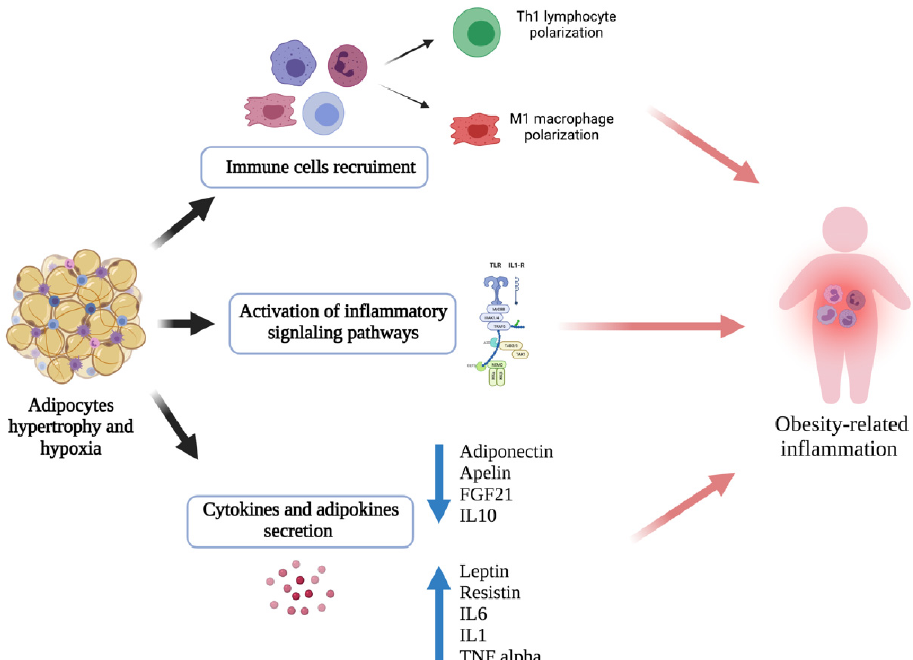
Figure 1. Adipose tissue and obesity ‐ related inflammation.